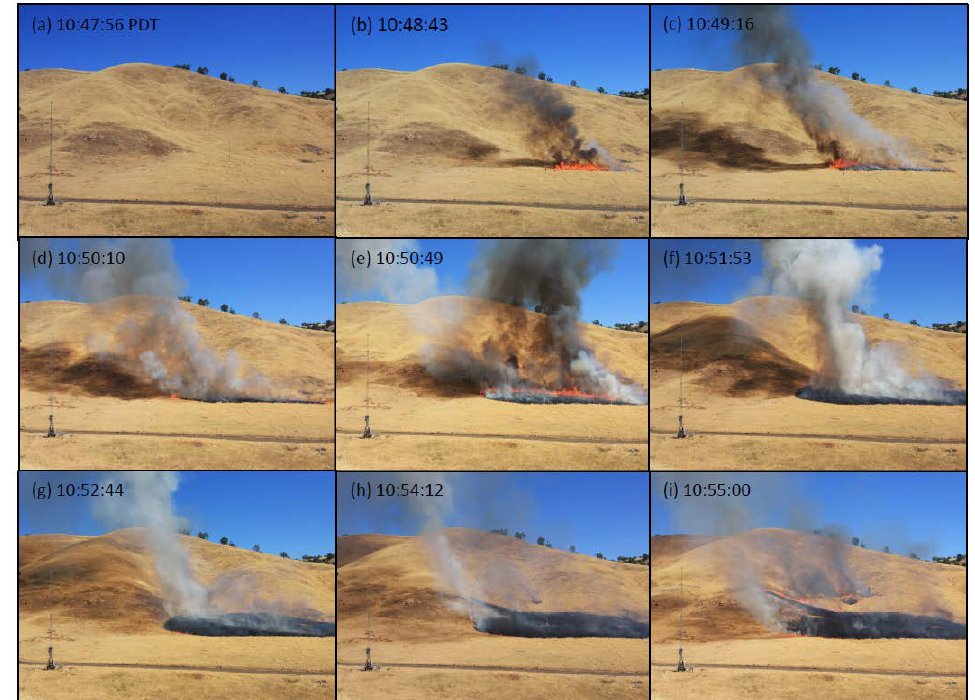
Figure 7. ( a – i ) Photographic time series fire front positions and plume structures. Times indicted are HH:MM:SS (PDT). Please refer to Figure 1 for plot orientation; camera was located at lidar location.